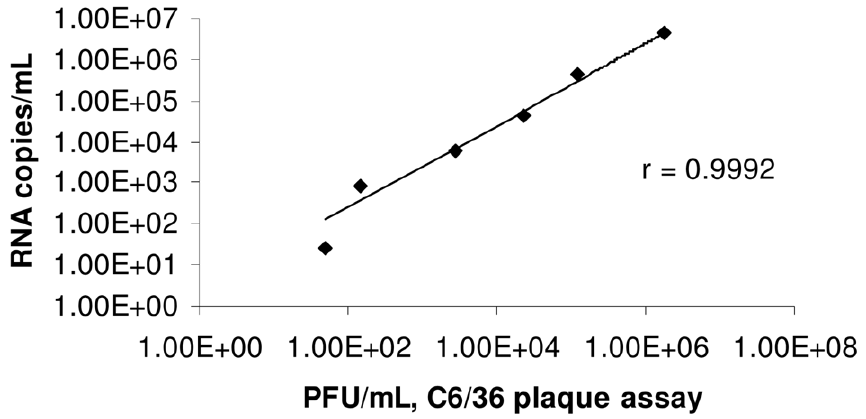
Figure 1. Correlation of CxFV Izabal qRT-PCR with C6/36 cell plaque titration. Samples from each dilution were split such that each dilution was quantified by both qRT-PCR and plaque assay. In this figure, the CxFV Izabal qRT-PCR assay used primers E92F and E151R and probe E112P. Results for other CxFV Izabal primer/probe sets are similar (data not shown).